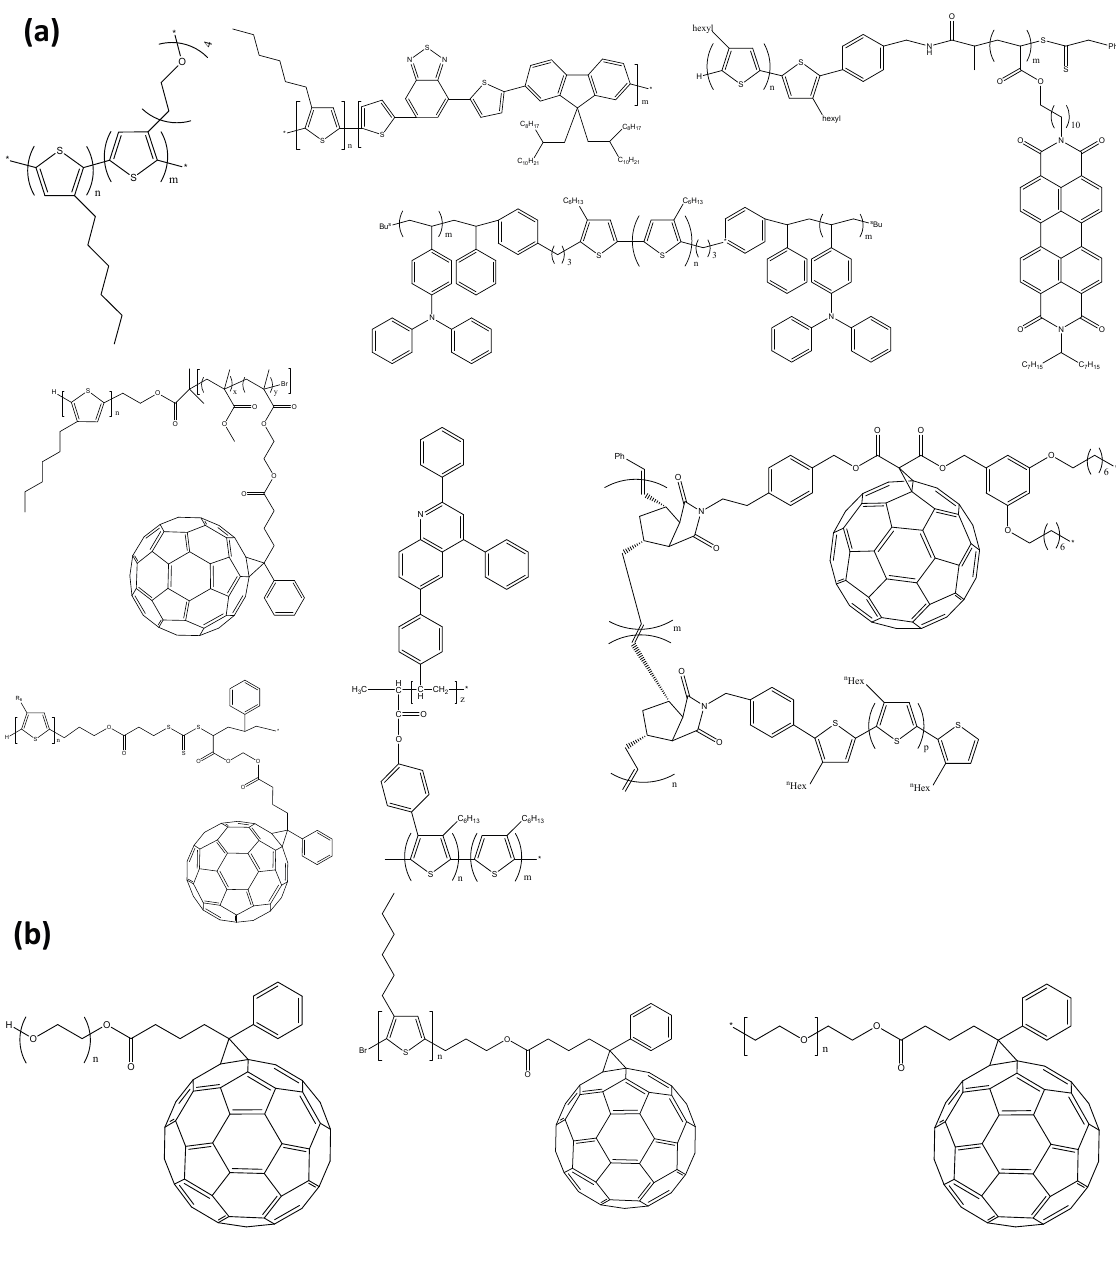
Figure 1. Representative ( a ) copolymers and ( b ) homopolymers as morphological control agents. Reprinted with permission from [37] copyright 2010 American Chemical